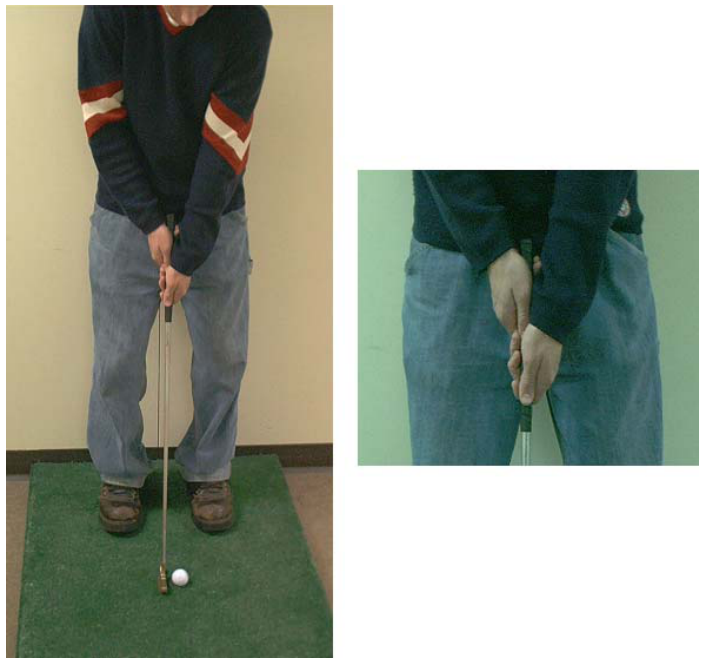
FIGURE 7 . (A) Overall view of cross-hand grip for putting in a novice player (GH), where the right hand is above the left hand. (B) Close-up view of the cross-hand grip.